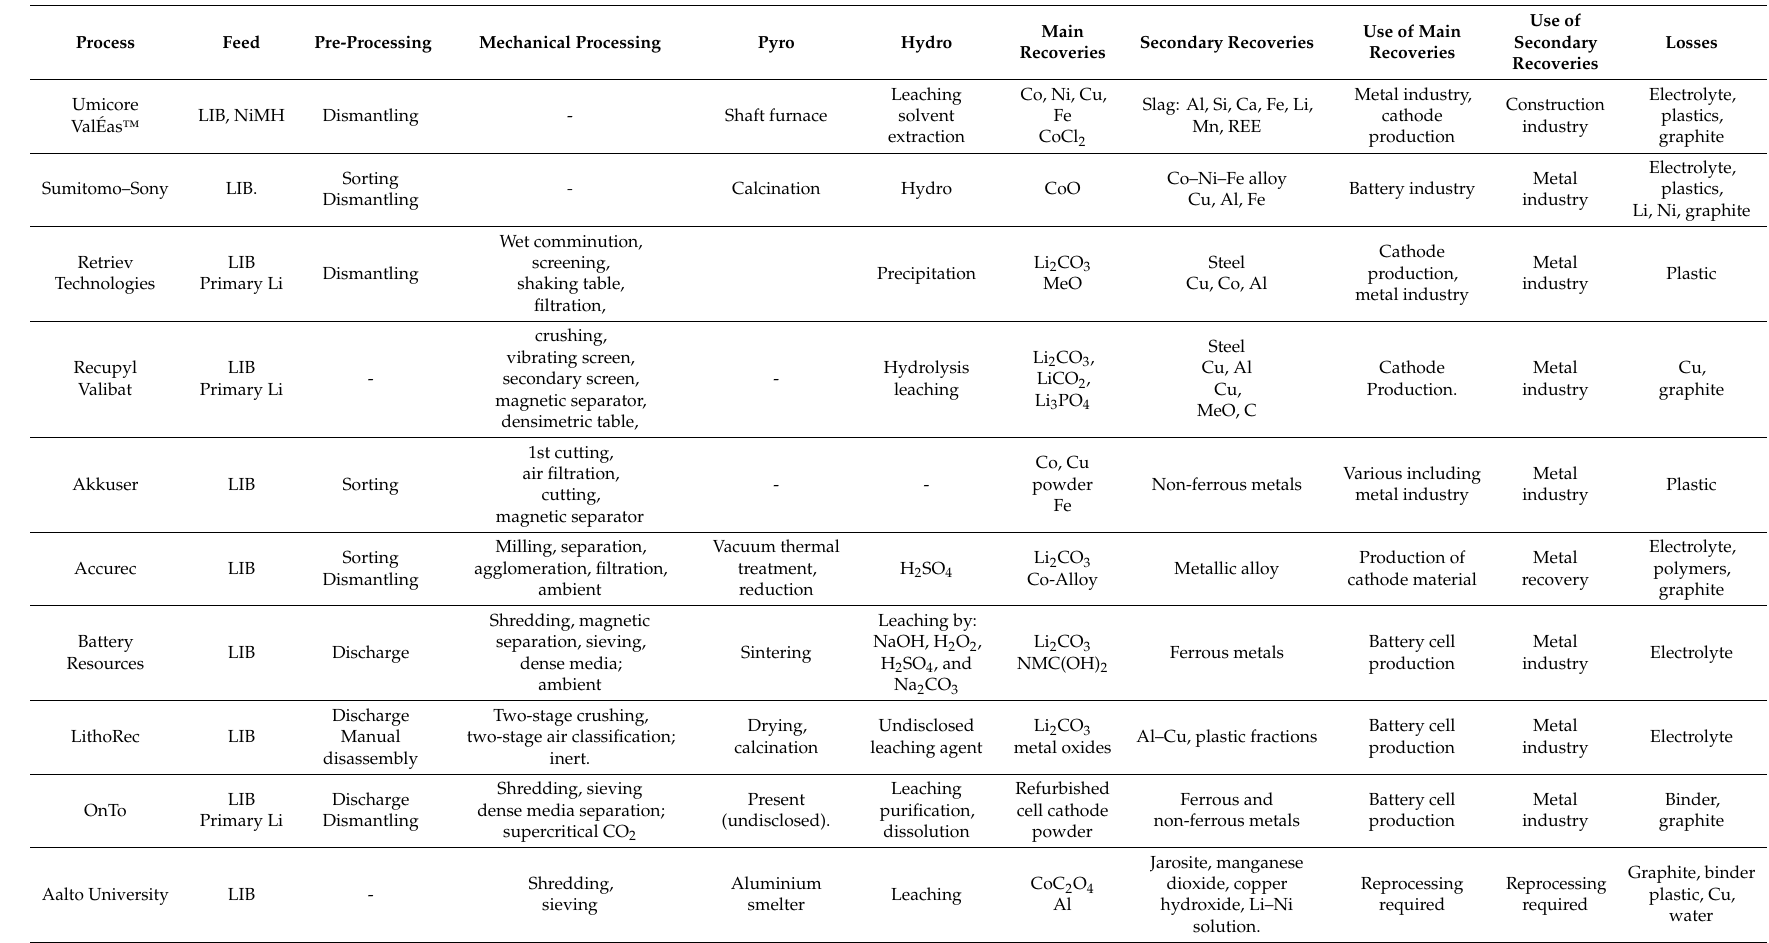
Table 2. Summary of LiB recycling